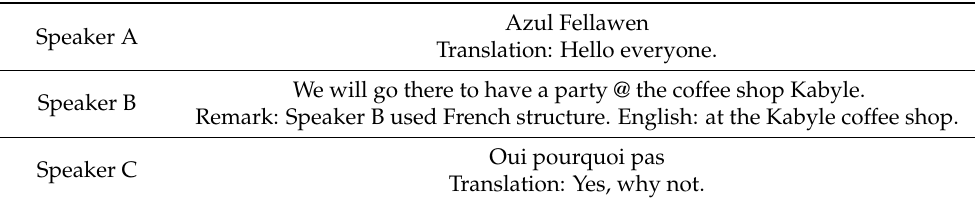
Table 2. Speech displaying typical use of multilingual